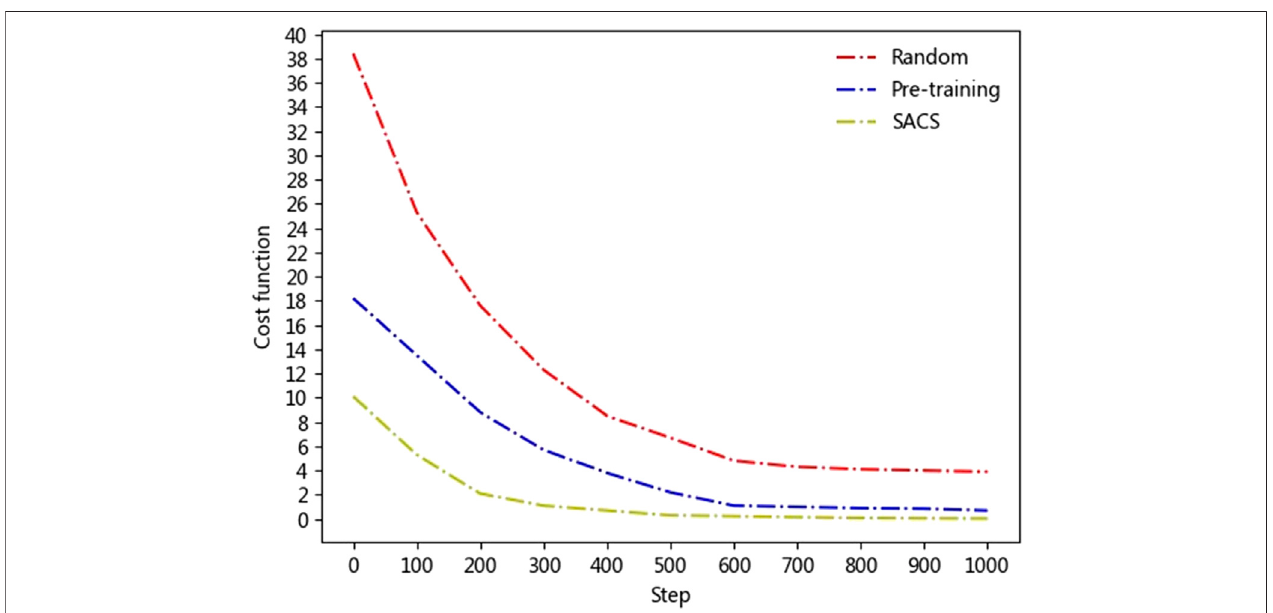
FIGURE 3 | Comparison of different initialization